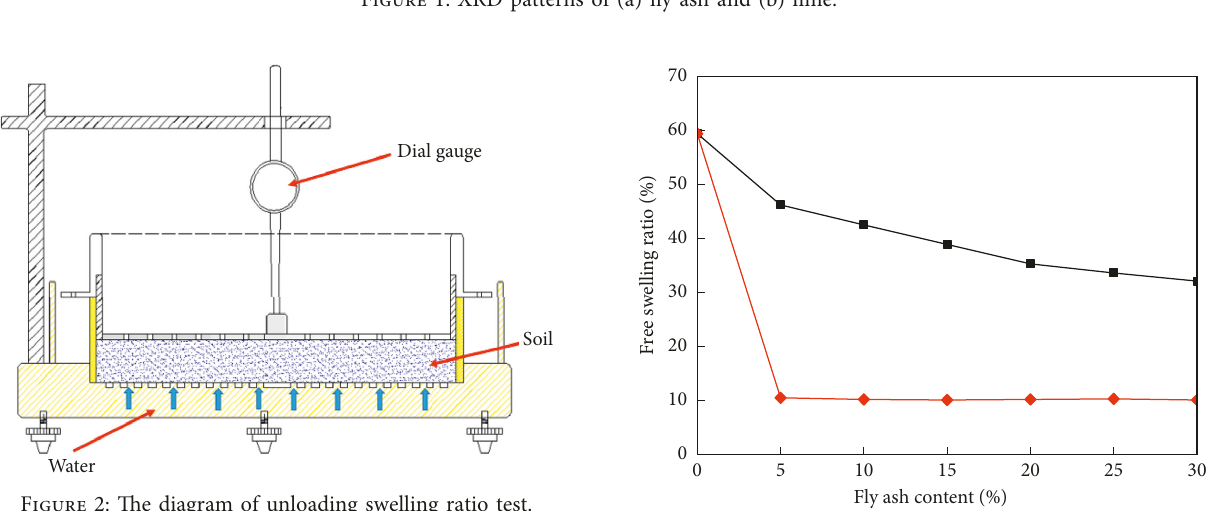
Figure 1: XRD patterns of (a) fly ash and (b) lime.